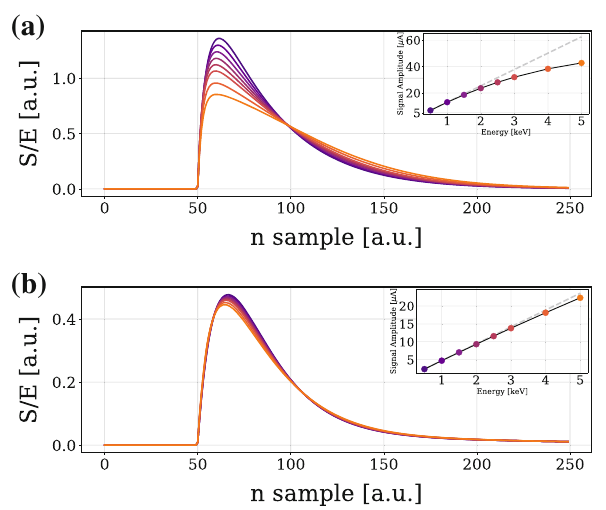
Fig. 4 Pulse profiles corresponding to different energies from 0.5 to 5 keV for two different detectors with non-linear (det. a), and nearly- linear response (det. b). In order to compare the signals, all the pulses are normalized by dividing their amplitude by the energy